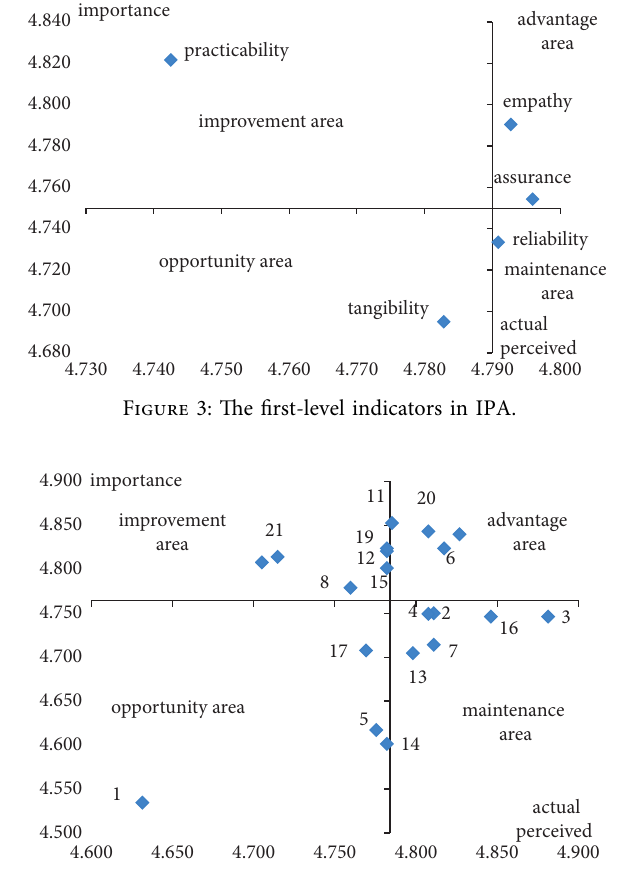
Figure 4: The second-level indicators in IPA.